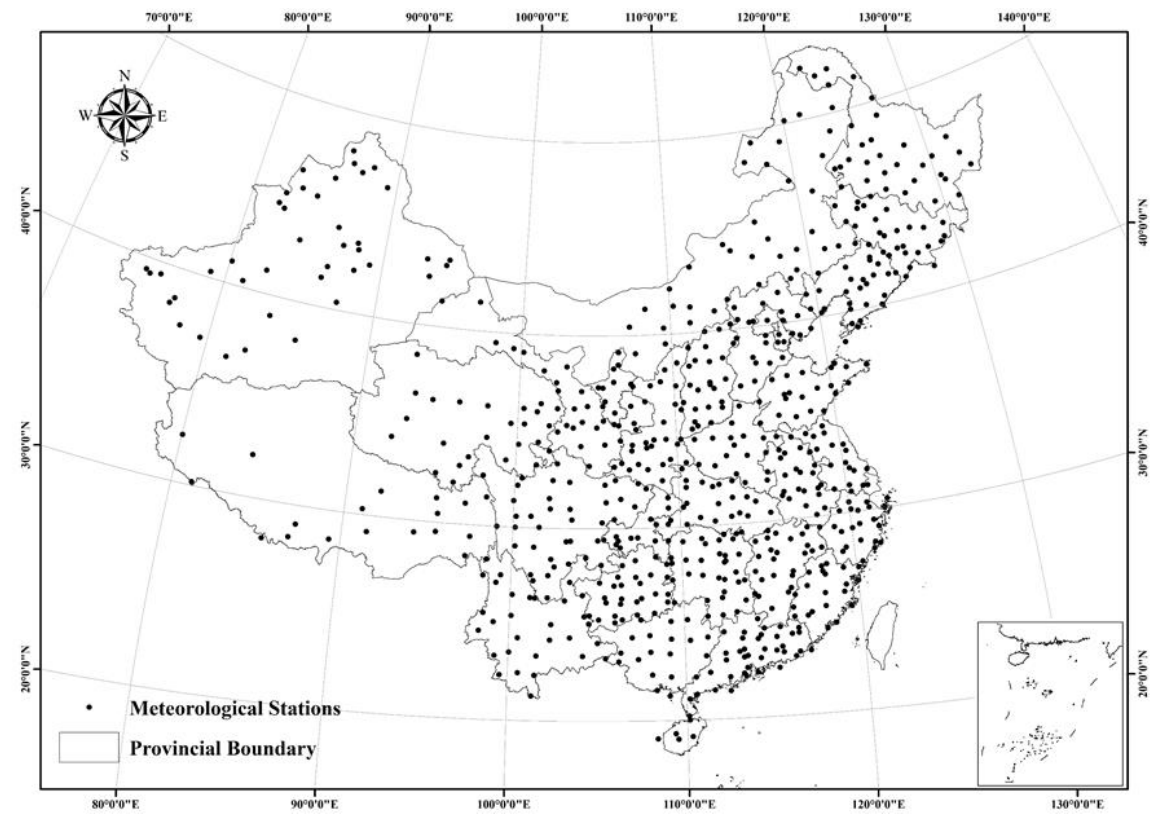
Figure 1. Administrative division map of China and the distribution of meteorological stations.